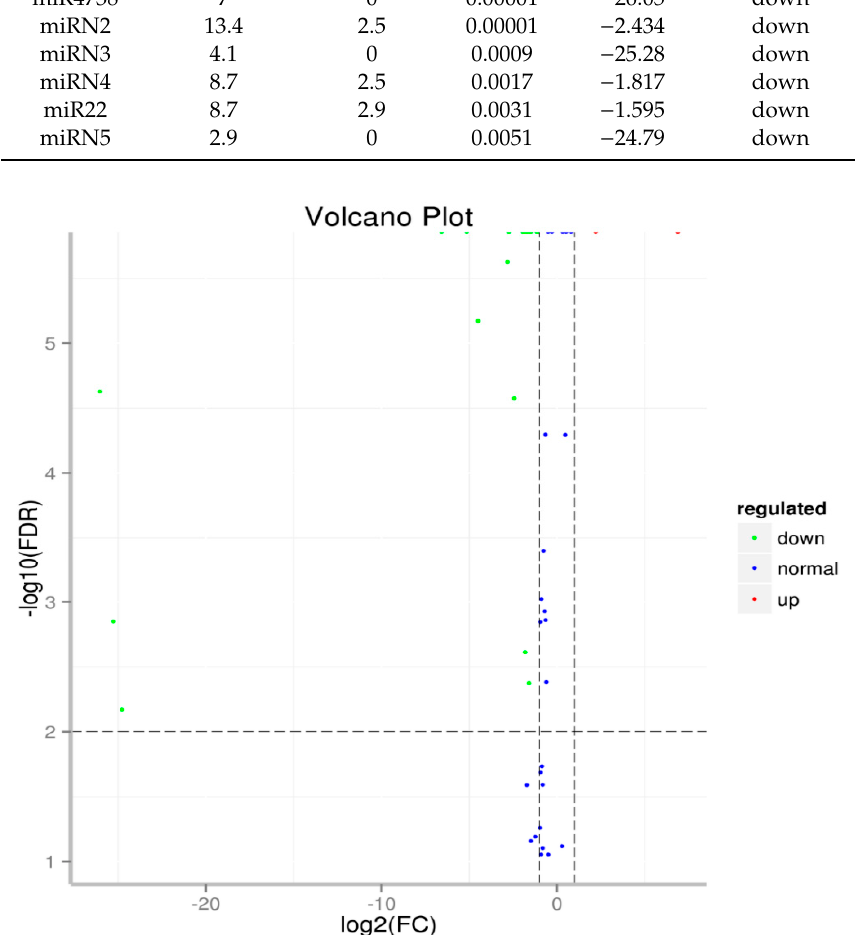
Figure 7. Volcano plot of microRNA expression in two developmental stages of RKN. In this figure, each spot represents an individual miRNA. The x-axis represents the fold change of each miRNA at log 2 level between eggs and J2 juveniles. A bigger number means a bigger fold change. The y-axis represents the significance level, a bigger number means higher significance. An miRNA in blue means that it has no significant change between the two developmental stages; the red spots mean significantly upregulated miRNAs in J2 juveniles compared with in eggs ( p < 0.01); the green spots mean significantly downregulated miRNA in the J2 stage ( p <